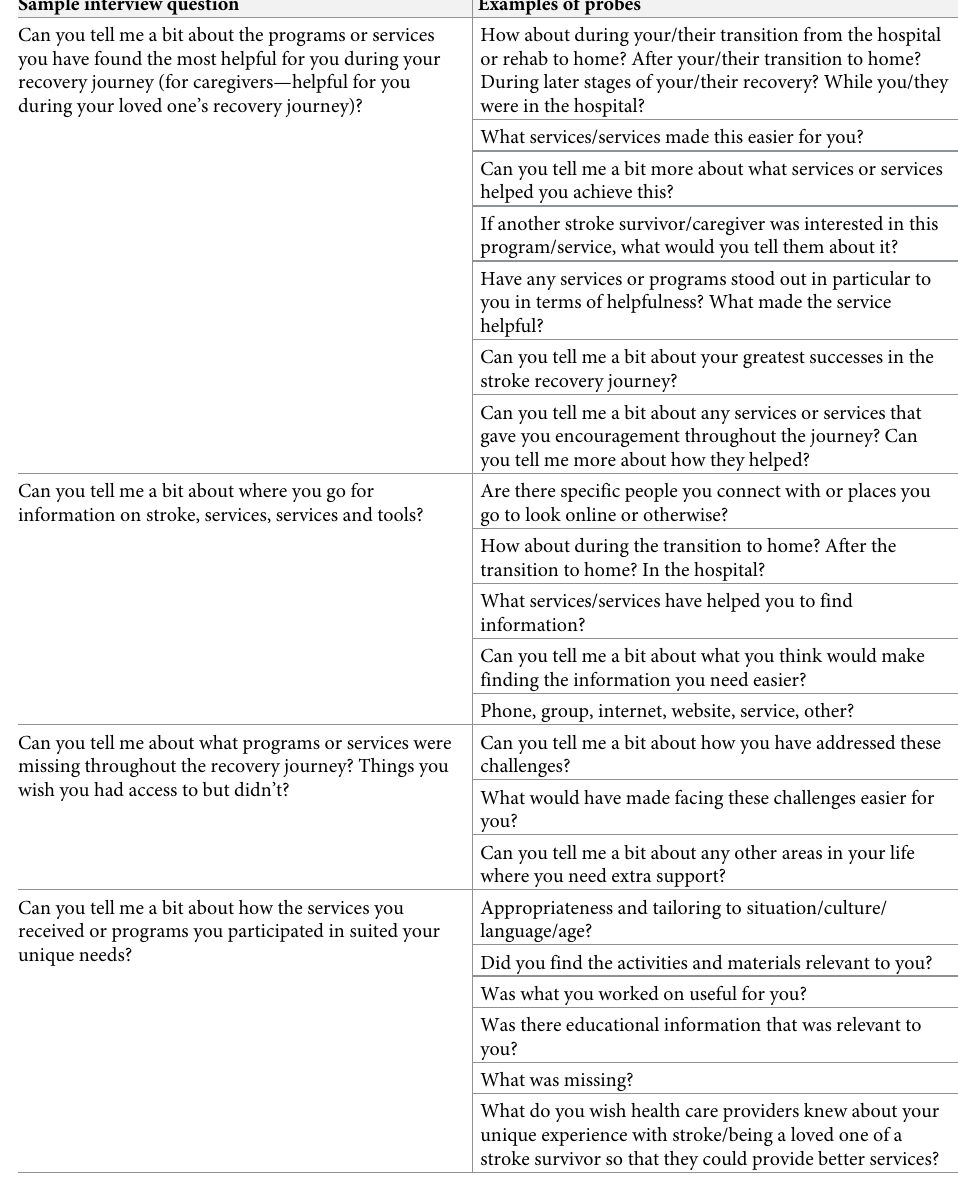
Table 1. Sample interview questions for interview